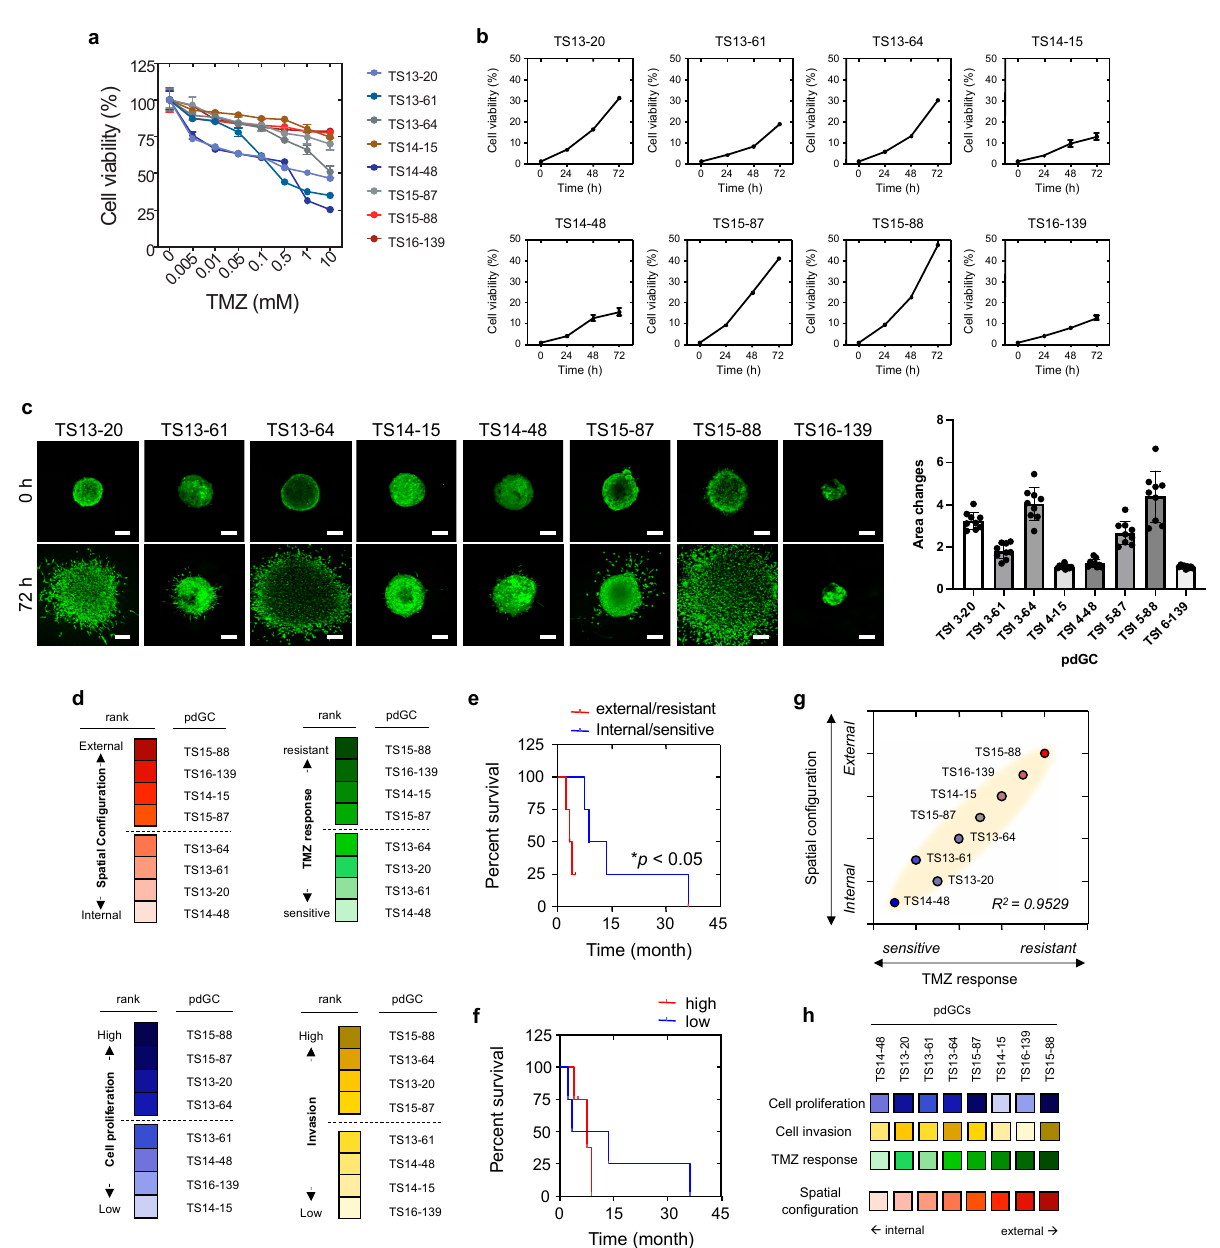
Figure 4. Phenotypic correlations with spatial configuration of pdGCs MAs. ( a ) pdGC viability in response to temozolomide (TMZ). ( b ) Graphs for all pdGCs proliferation over time for 72 h. ( c ) Fluorescent images and quantification of pdGCs after 72-h invasion. Scale bar: 100 µ m. ( d ) Ranking of pdGC TMZ response (sensitive to resistance), pdGC proliferation (low to high), and pdGC invasion (low to high) by color-code. ( e ) Kaplan–Meier survival plot of patients whose pdGCs were classified in terms of MA TMZ response and 3D spatial configuration. Statistical significance: * p < 0.05. ( f ) The Kaplan–Meier survival graph of patients whose pdGCs were classified in terms of MA proliferation and invasion. ( g ) Correlation between the drug response and 3D spatial configura- tion. ( h ) Comparative pdGC heatmap of the associations of cellular proliferation and invasion, as well as TMZ response, with 3D spatial configuration in